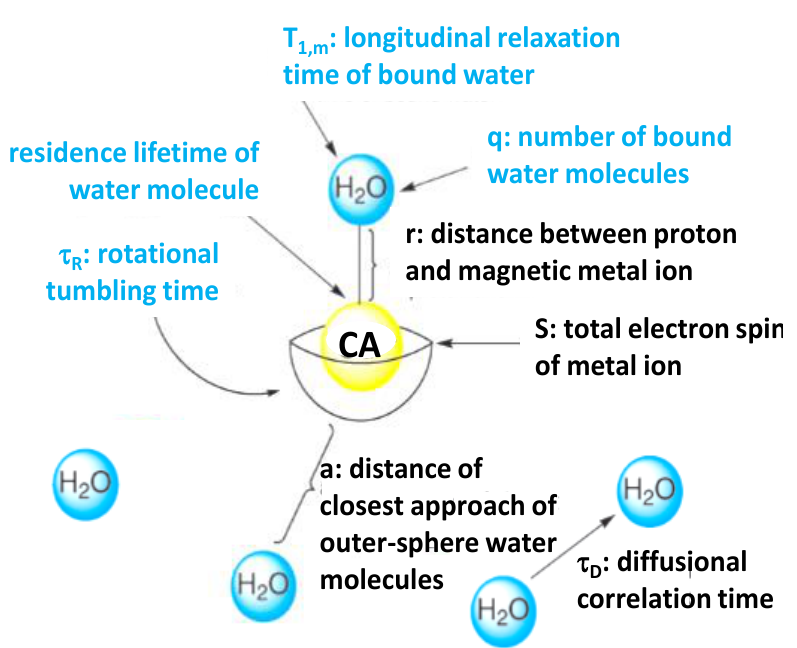
Figure 1. Variables contributing to CA relaxivity in the inner- ( in blue ) and outer-sphere ( in black ) mechanisms. Reproduced from [20], with permission from RSC, 2009.